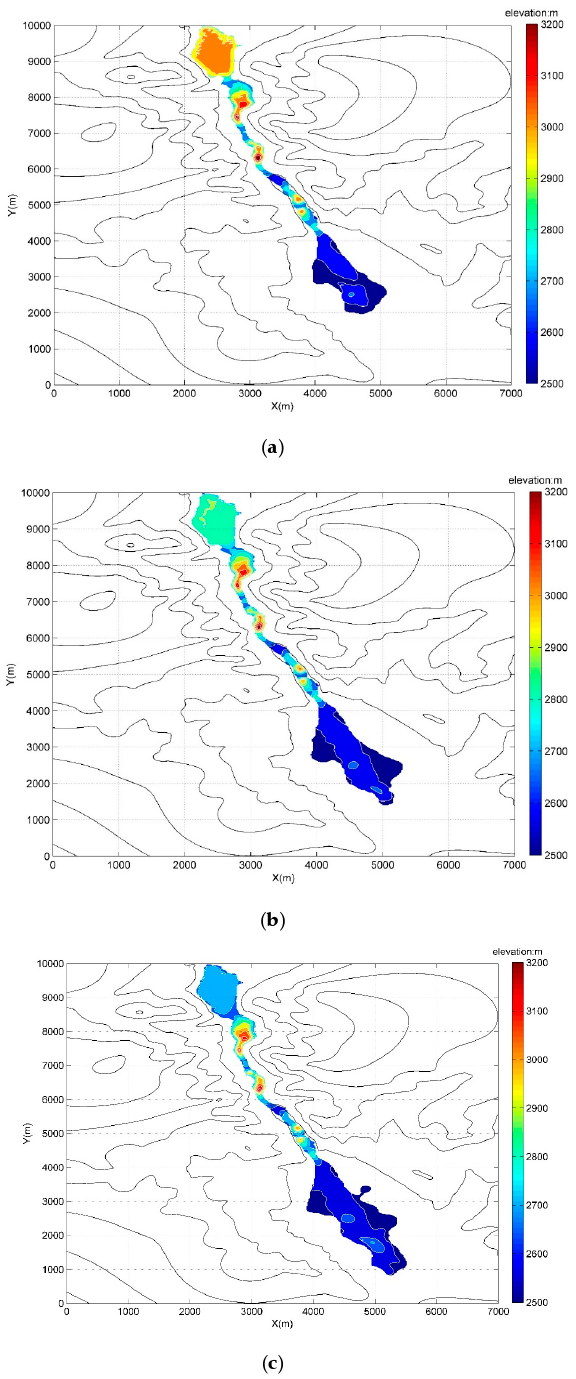
Figure 15. Flood maps at t = 600 s after the dam break for different breach ratio conditions: ( a ) 60%; ( b ) 80%; and ( c ) 100%. ( b ) 80%; and ( c )